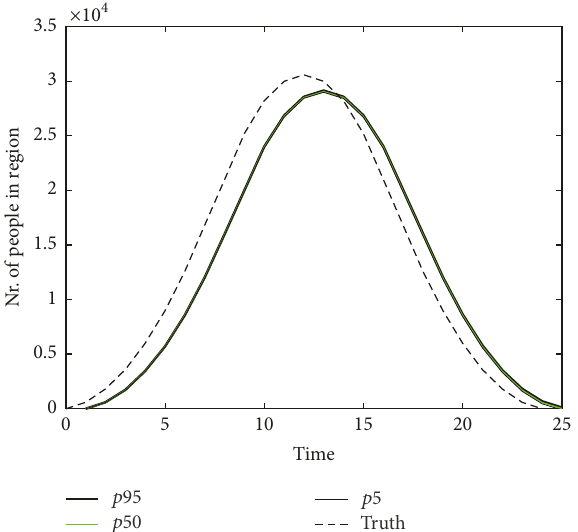
Figure 5: Case 1: visualisation of the solution space provided by the Monte Carlo simulation for 𝛼 𝑛 = 0.95 , where the dashed line of the total demand represents the ground truth, and 𝑝5 , 𝑝50 , and 𝑝95 represent the 𝑥 th percentile of the distribution of realizations of the amount of pedestrians in the area at time 𝑡